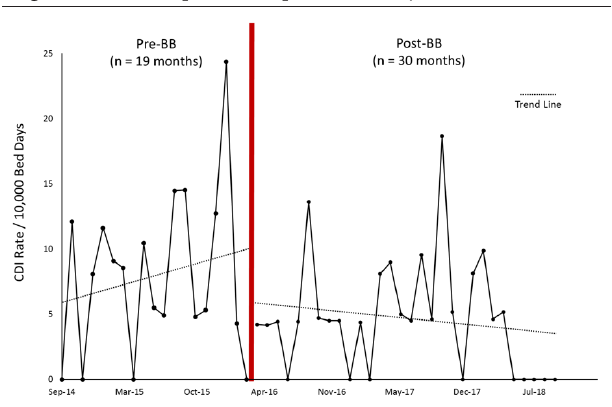
Figure 1: CDI rate per 10 000 patient bed days.